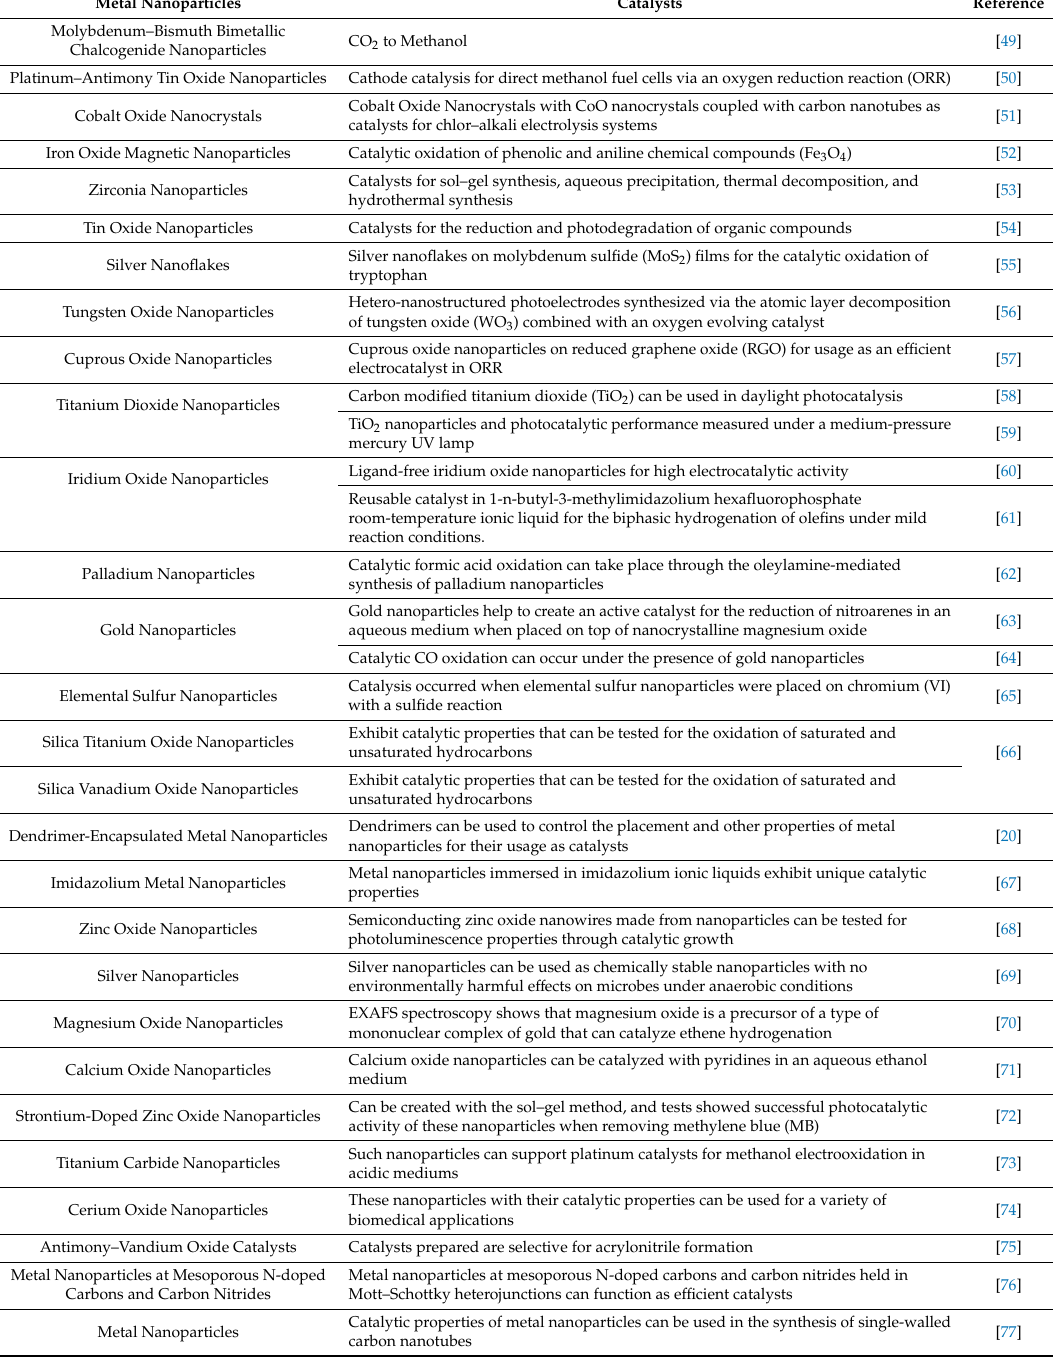
Table 1. Various metal nanoparticles synthesized and their catalytic